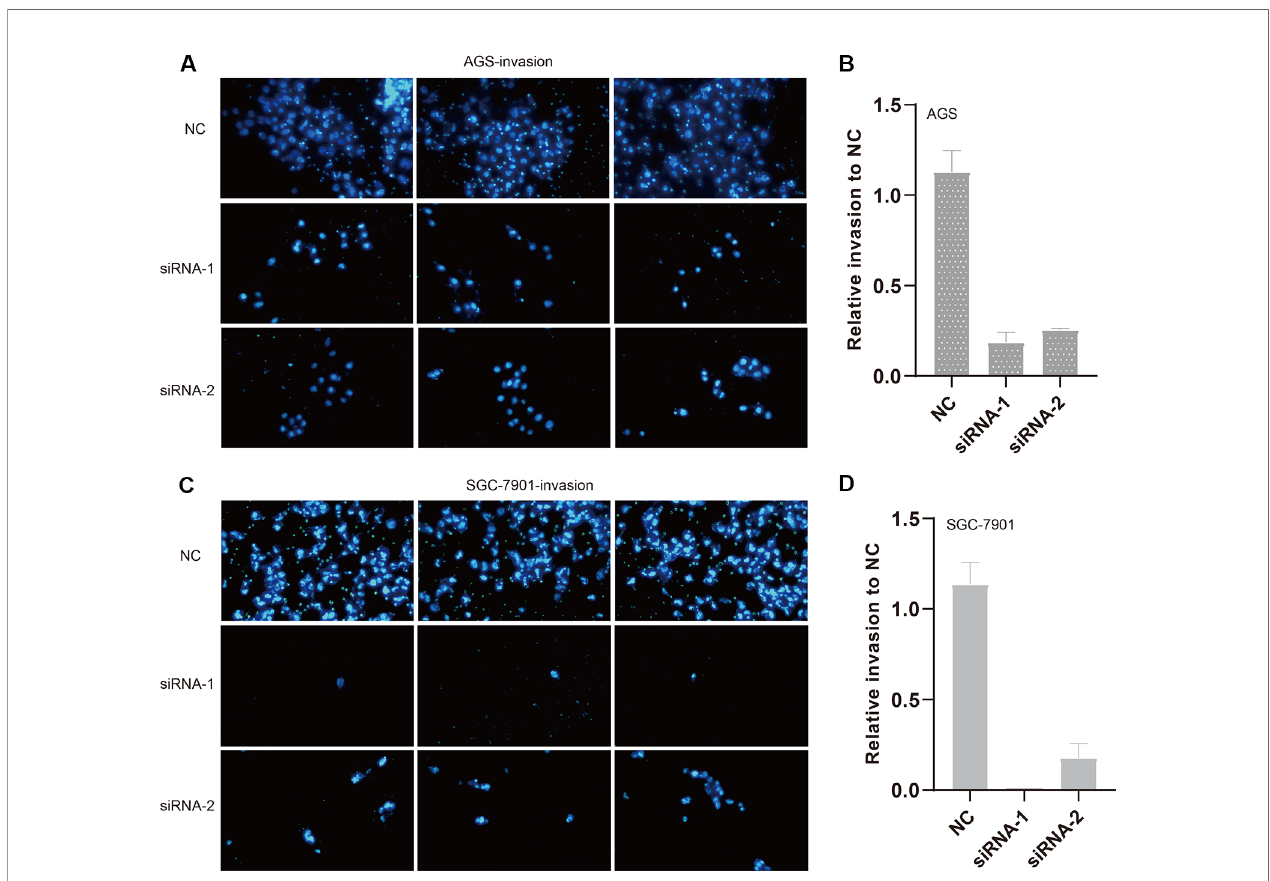
FIGURE 7 | Knockdown of ILF3-AS1 induced cell invasion in GC. (A, B) Knockdown of ILF3-AS1 induced cell invasion in AGS cells. (C, D) Knockdown of ILF3-AS1 induced cell invasion in SGC-7901